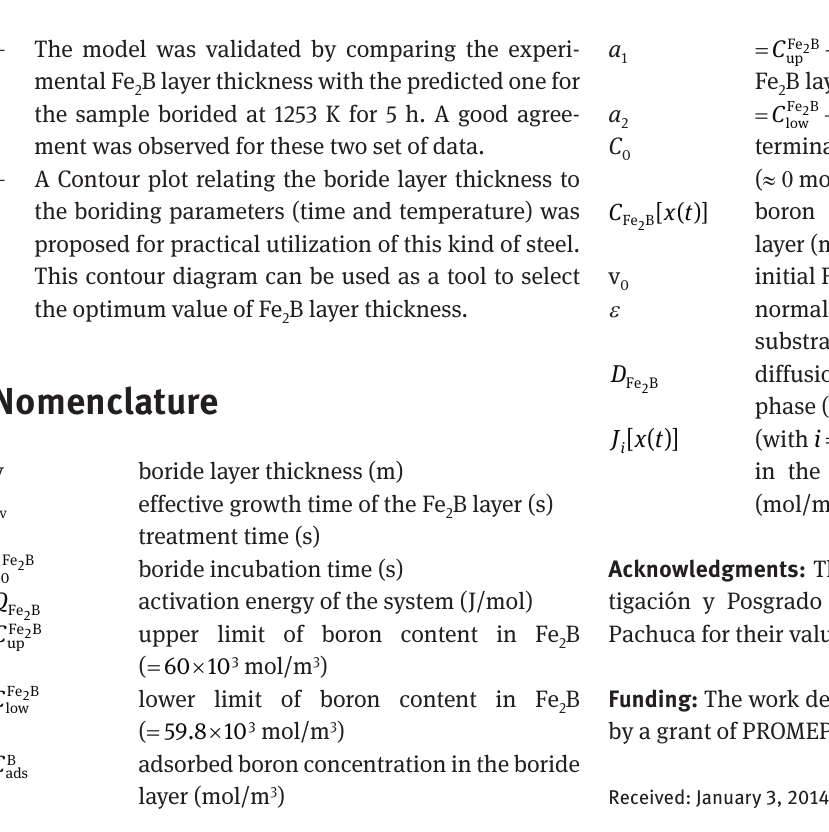
Fig. 12: Contour plot giving the Fe 2 B layer thickness as a function of boriding